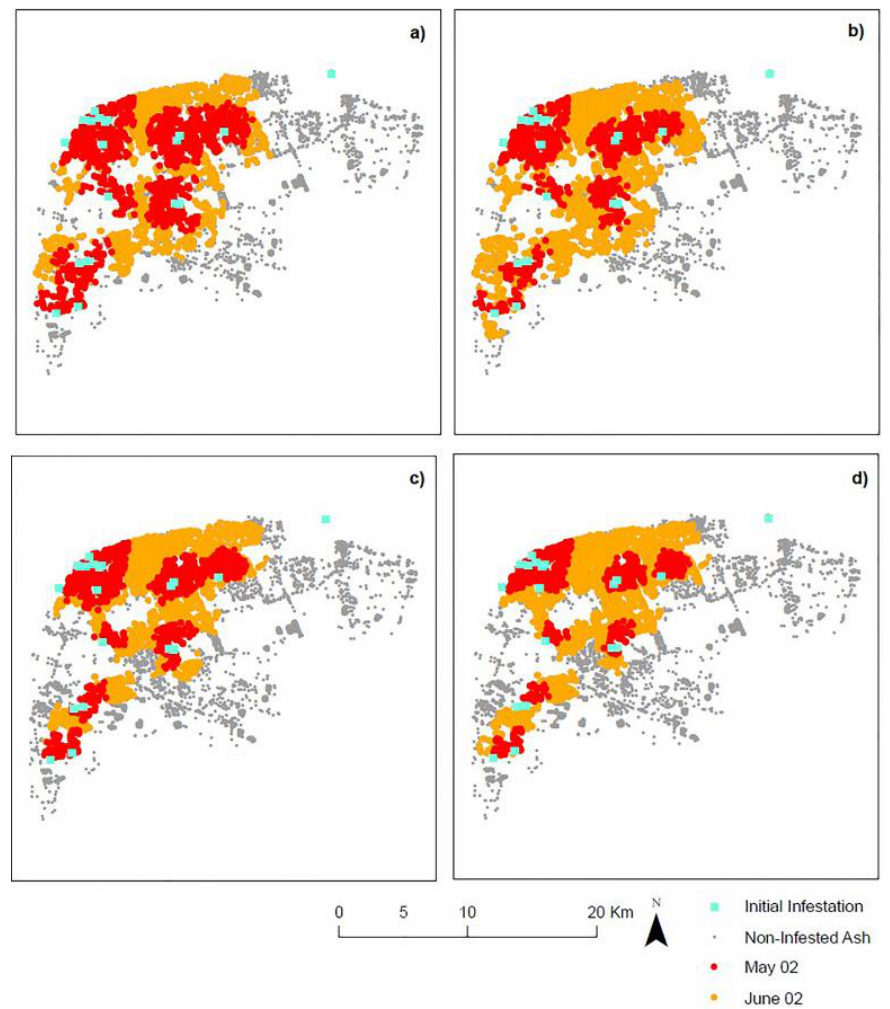
Figure 8. Simulation results generated for May and June 2002 comparing spatial patterns of EAB spread for ( a ) Urban Landscape Scenario and its changes with ( b ) temperature ( c ) wind and ( d ) combined wind and temperature.